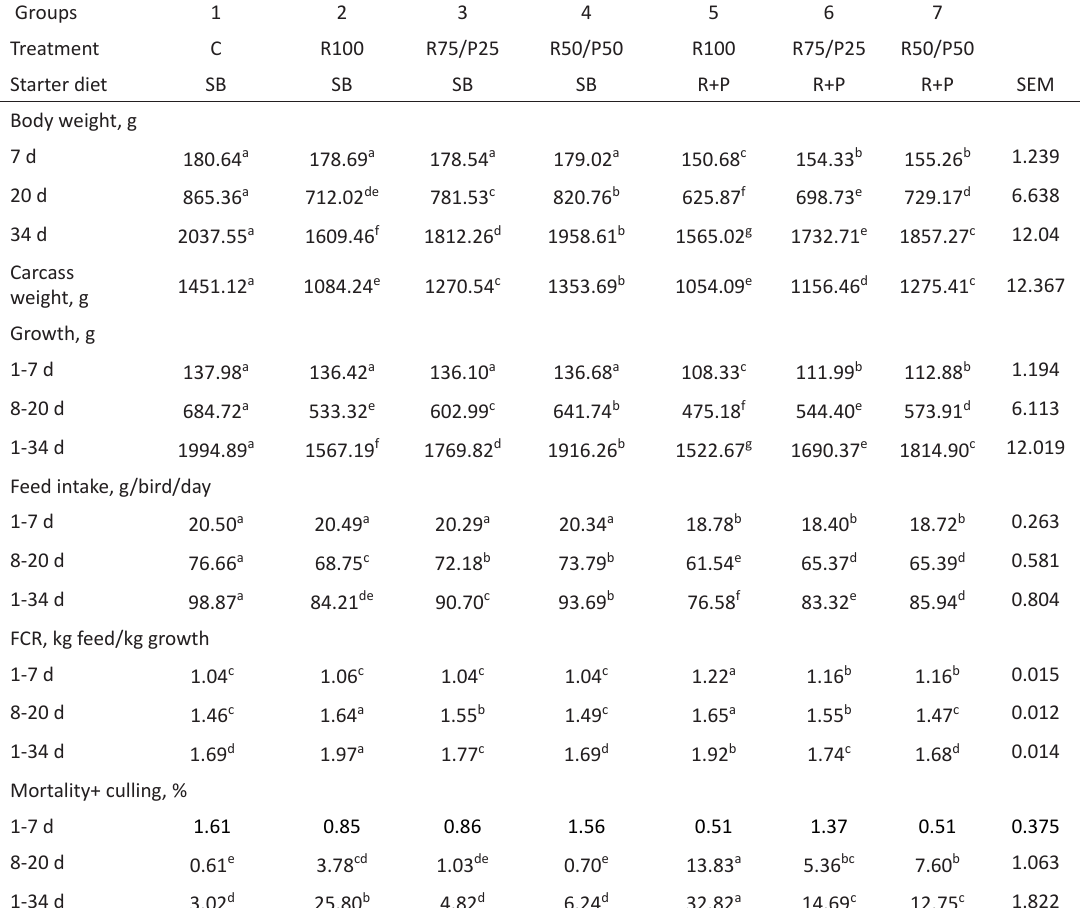
Table 4. The effect of diets with soybean meal (SB), rapeseed meal (R) , or rapeseed meal and peas (P) on broiler